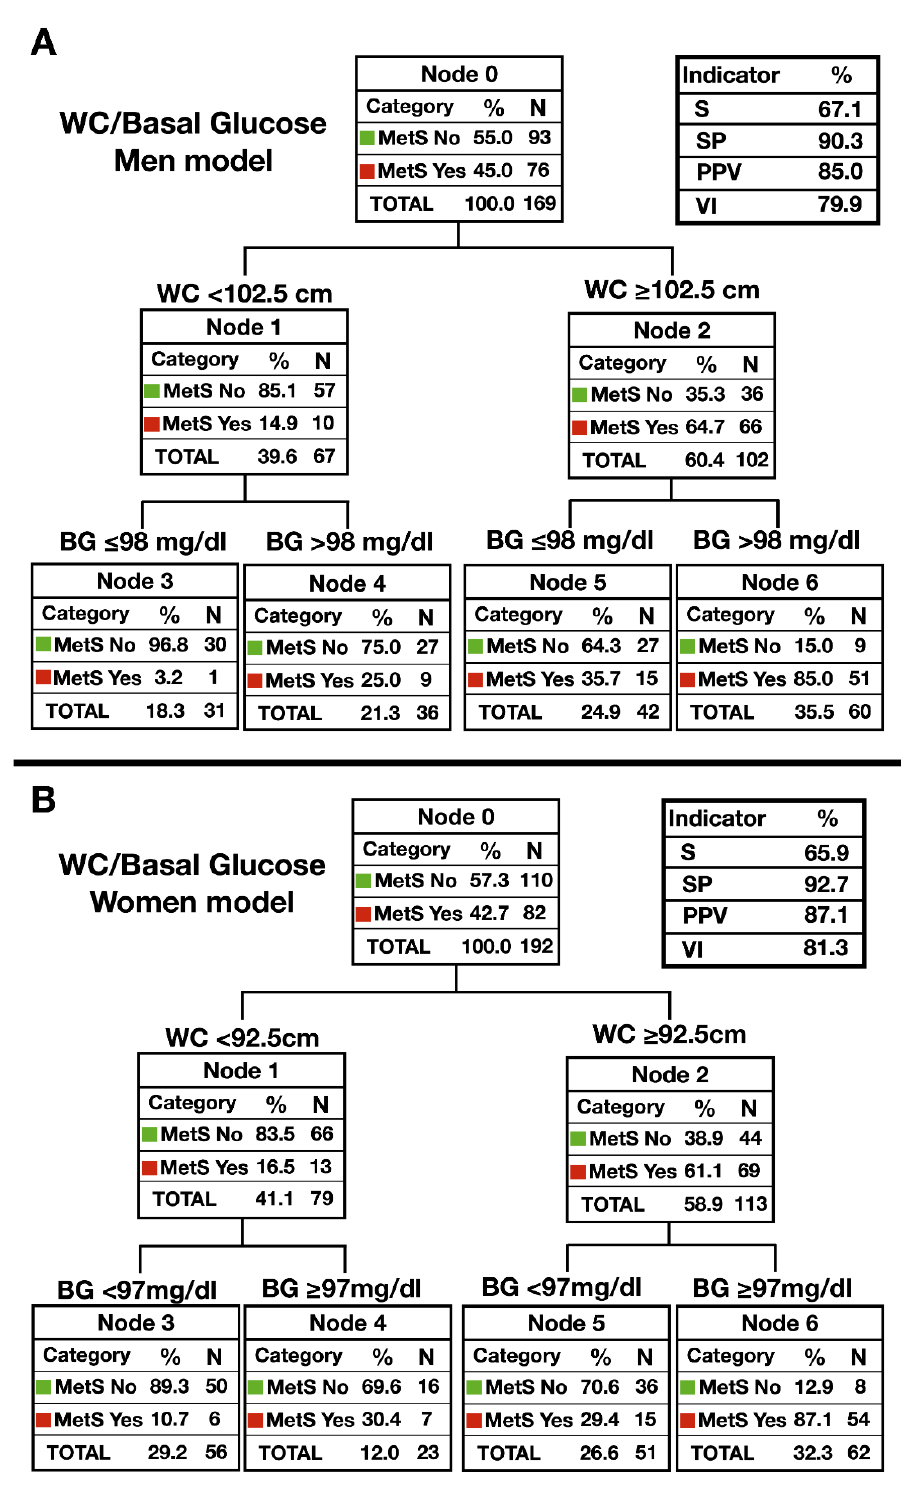
Figure 3. Diagnostic decision trees for detection of MetS in elderly women ( n = 82) and men ( n = 76). ( A ) Model that uses WC and basal glucose in older men; ( B ) Model that uses WC and basal glucose in older women. MetS: metabolic syndrome; WtHR: waist–height ratio, WC: waist circumference, BG: basal glucose. S: sensibility; SP: specificity; PPV: positive predictive value; VI: validity index.